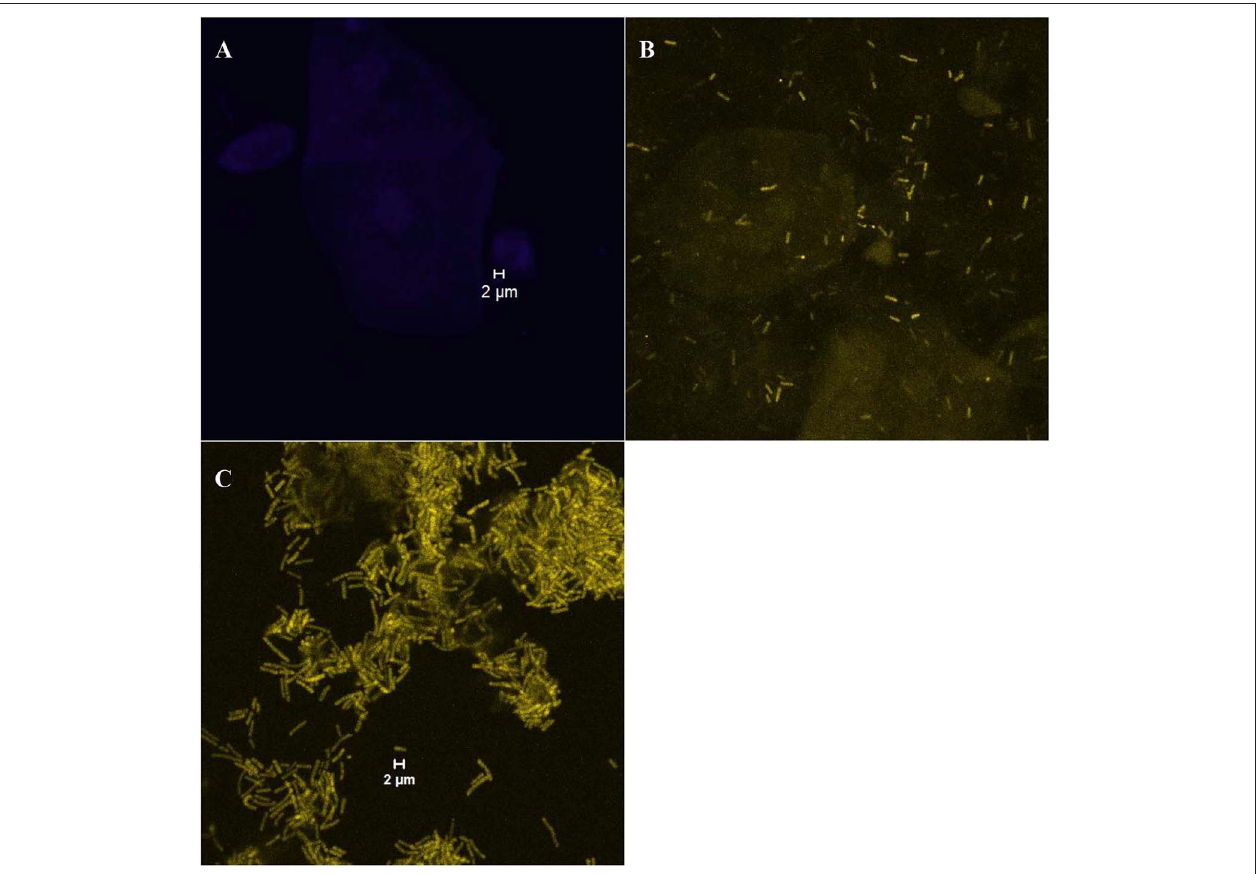
FIGURE 1 | Examples of different bacterial growth forms; (A) “absent” category with no bacteria present on vaginal cells (visualized with the laser diode 405 that detects the DAPI stain); (B) “dispersed” category [an example of scattered cells of Lactobacillus spp. (rods in yellow color) visualized with the helium-neon laser 2 that detects the Lab158-Cy3 probe]; (C) “biofilm” category ([an example of the Lactobacillus biofilm (rods in yellow color) visualized with the helium-neon laser